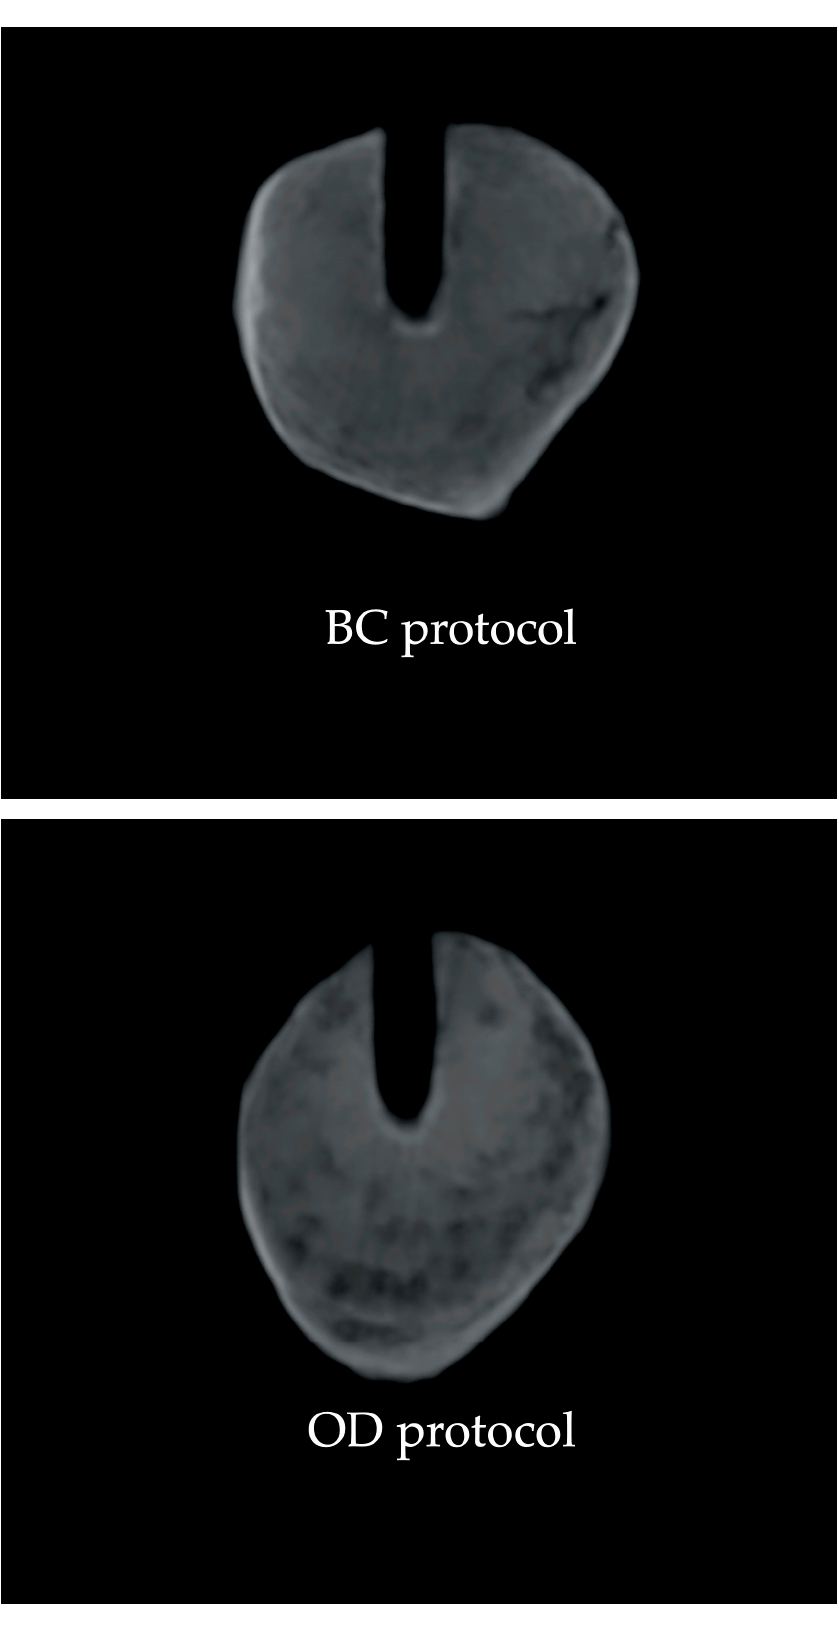
Figure 6. CBCT scans show a hyperdense border along the implant bone walls at the end of the osteotomies procedures: bone compactors (BC); osseodensification drills (OD).